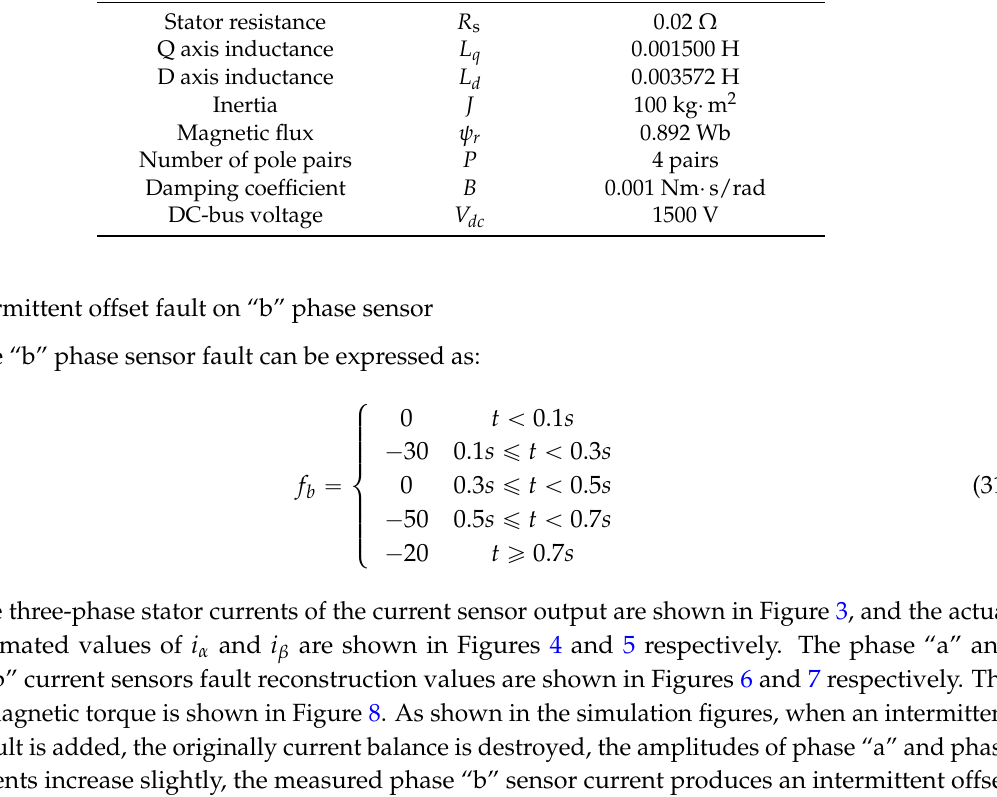
Table 2. Interior PMSM parameters.